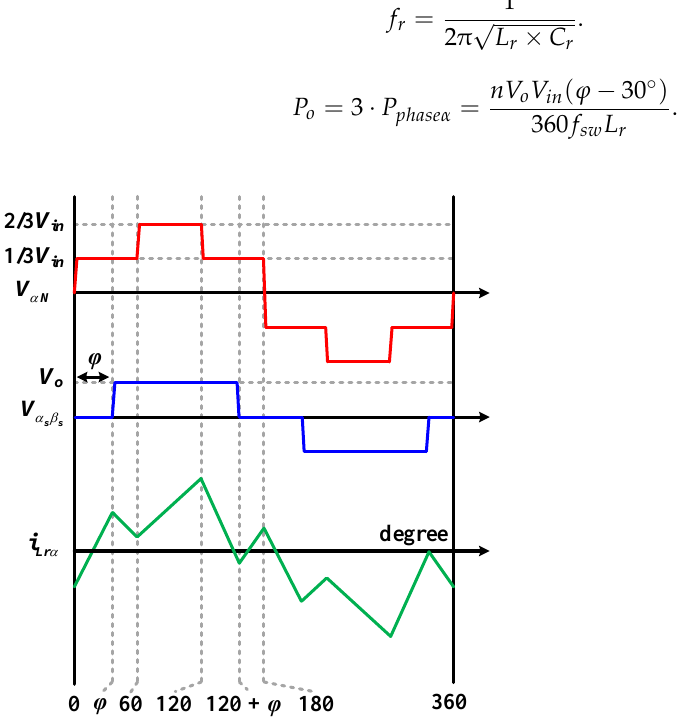
Figure 3. Primary and secondary-side phase voltage and inductor currents of the one phase. Equation (2) can explain the elements that can use the phase shift degree ϕ and switching frequency f s w to regulate output power P o . Figure 4 depicts the